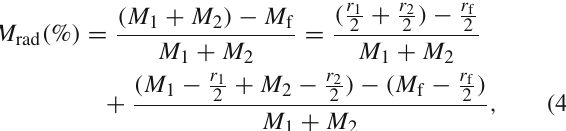
( a ) The upper limit of the mass of the dilaton hair radiated √ out in α = 1 / 16 and γ = 2. Fig. 5 The upper limits of the radiation of a dilaton hair for the collision of two dilatonic black holes